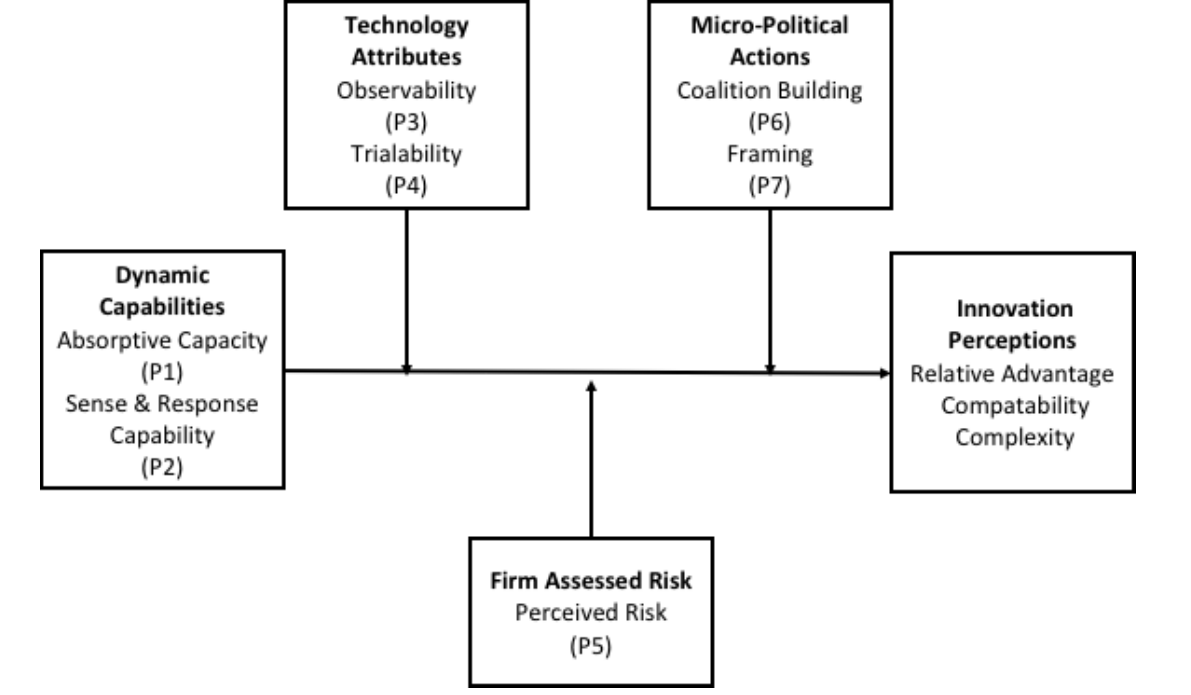
Figure 1. Firm-Level Technology Adoption